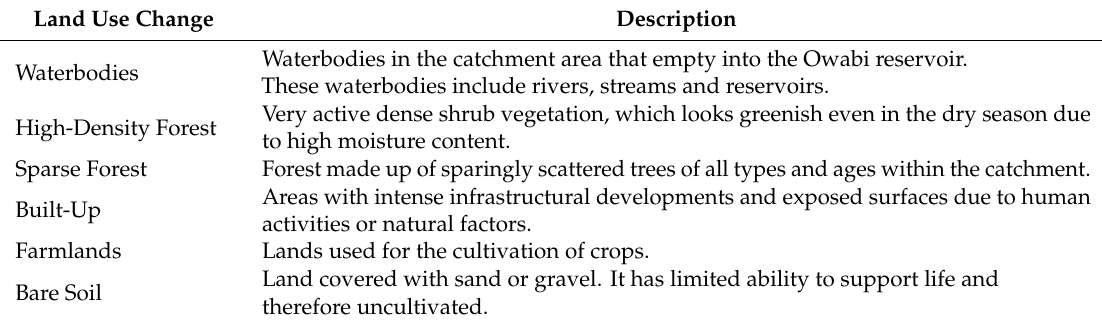
Table 2. Description of land use / land cover classification schemes used in this